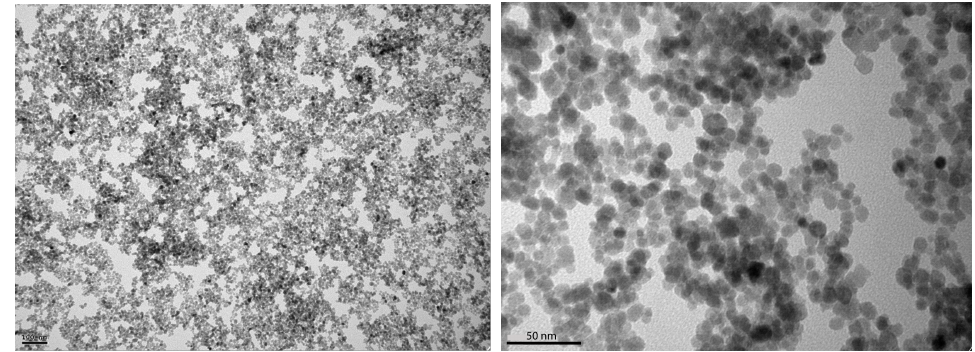
Figure 5. JEOL JEM 1011 TEM images of the superparamagnetic iron oxide NPs with Gatan ES1000Ww